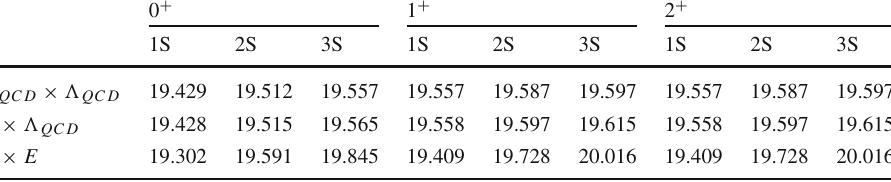
Table 4 The spectra of the bb - ¯ b ¯ b states with m bb = 9 . 8